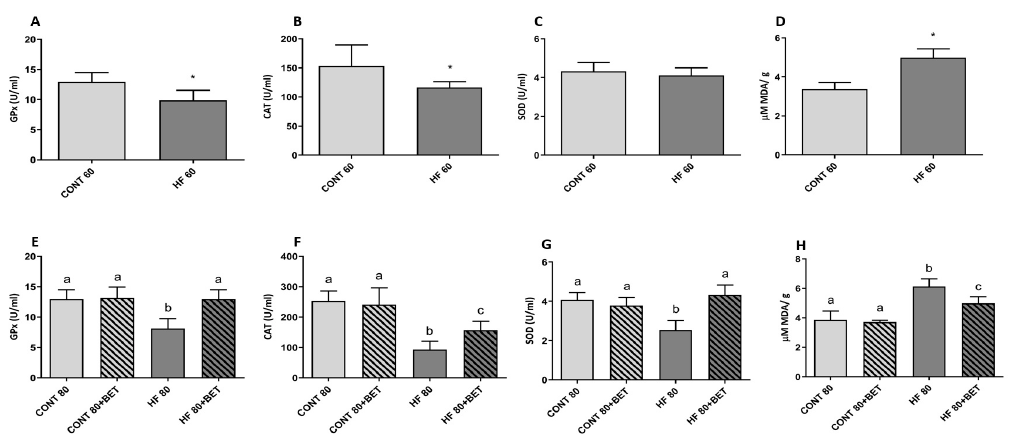
Figure 2. Antioxidant activity of glutathione peroxidase (GPx) ( A ), catalase (CAT) ( B ), superoxide dismutase (SOD) ( C ), and liver malondialdehyde (MDA) ( D ) concentrations after phase 1 and GPx ( E ), CAT ( F ), SOD ( G ), and MDA ( H ) after phase 2 of high-fat feed intake. The symbol* in Figures 2A,B,D indicates differences between the CONT 60 (control group fed the standard feed AIN-93G)and HF 60 (high-fat group fed the hyperlipidemicfeed)at a p < 0.05 significance level. Different letters in Figures 2E–H indicate differences at a p < 0.05 significance level.